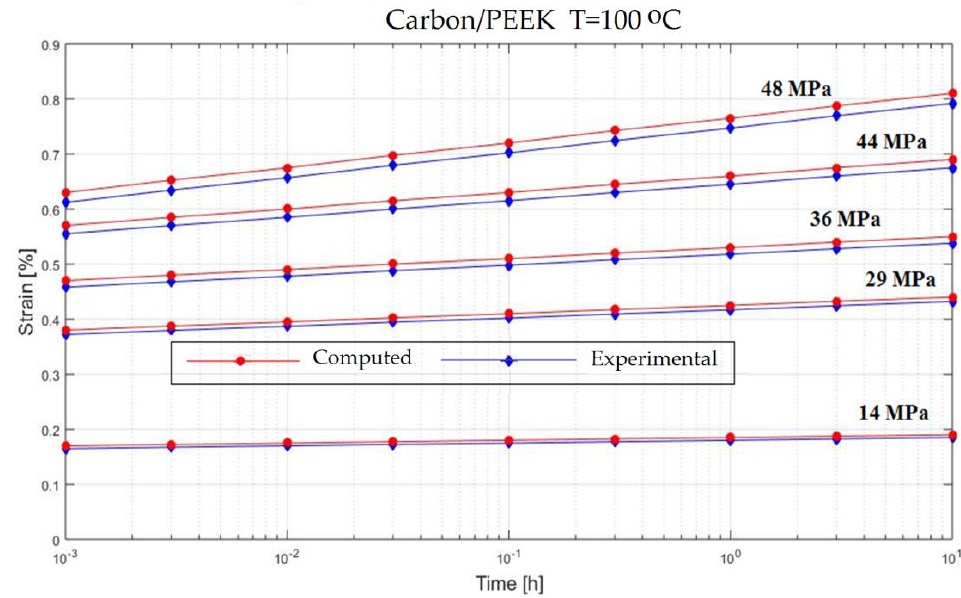
Figure 6. Creep response of a carbon/epoxy {90} 4s at T = 80 ° C.